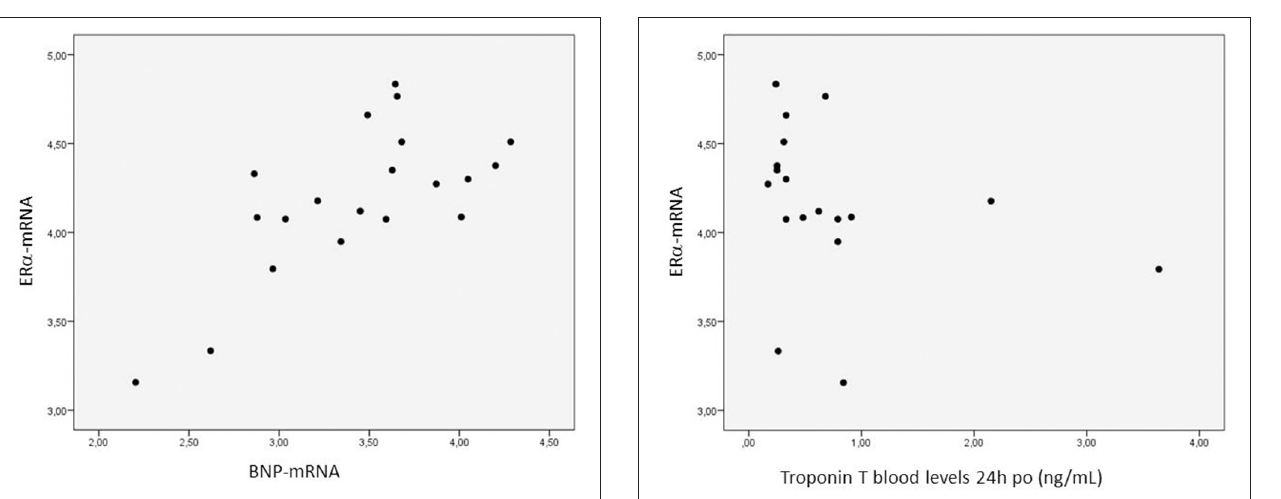
FIGURE 2 | Relationship between the myocardial expression of ER α - and BNP-mRNA. N = 20. Spearman correlation coefficient: 0.930, p = 0.021. The expression of mRNA of the target gene is corrected for that of 18S.